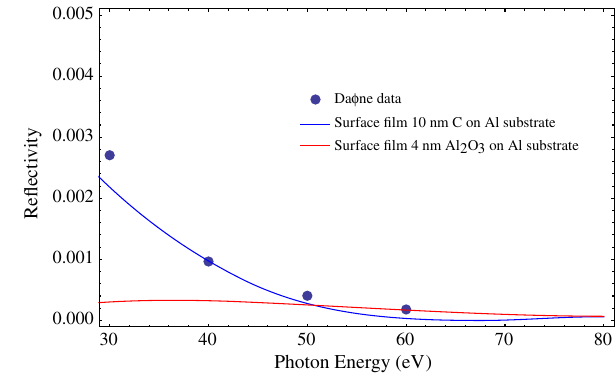
FIG. 9. Comparison of data [18] and model for diffuse scattering at 5° from a rough ( σ ¼ 200 nm) surface layer on an aluminum substrate.